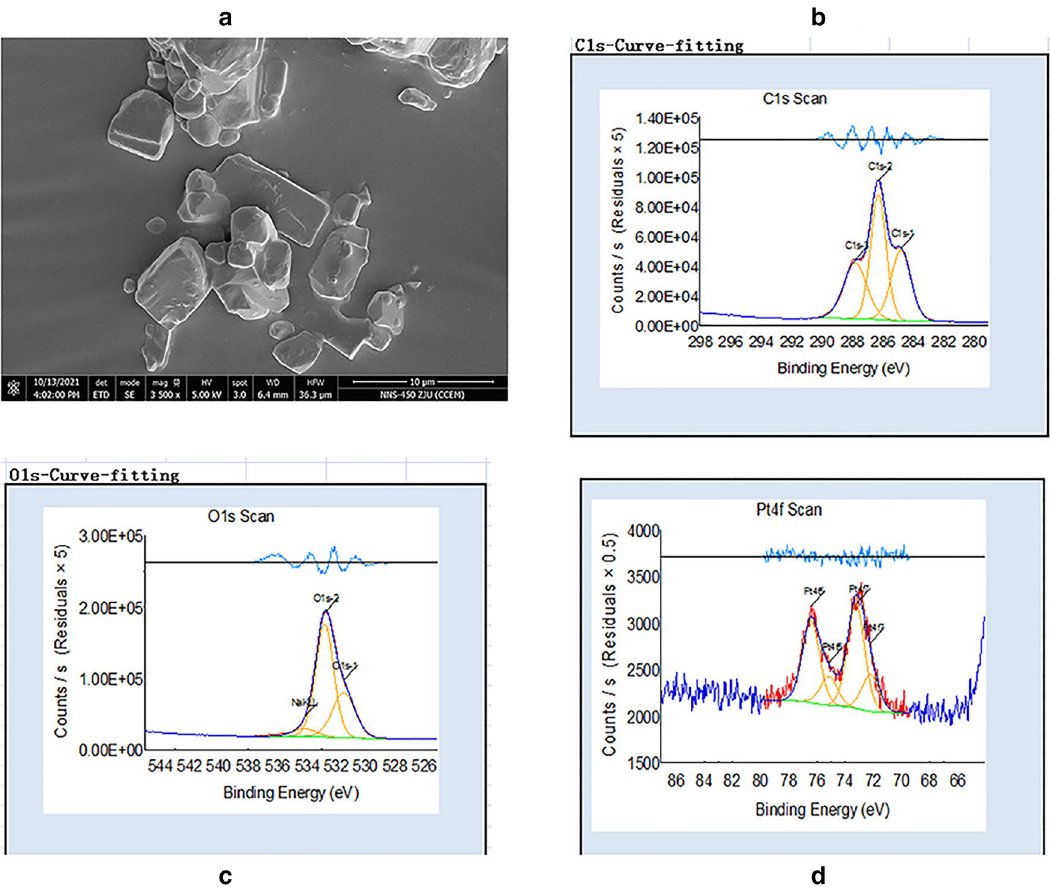
Figure 3. ( a ) SEM images of OP-145 PLGA; ( b - d ) X-ray photoelectron spectroscopy analyses of OP-145